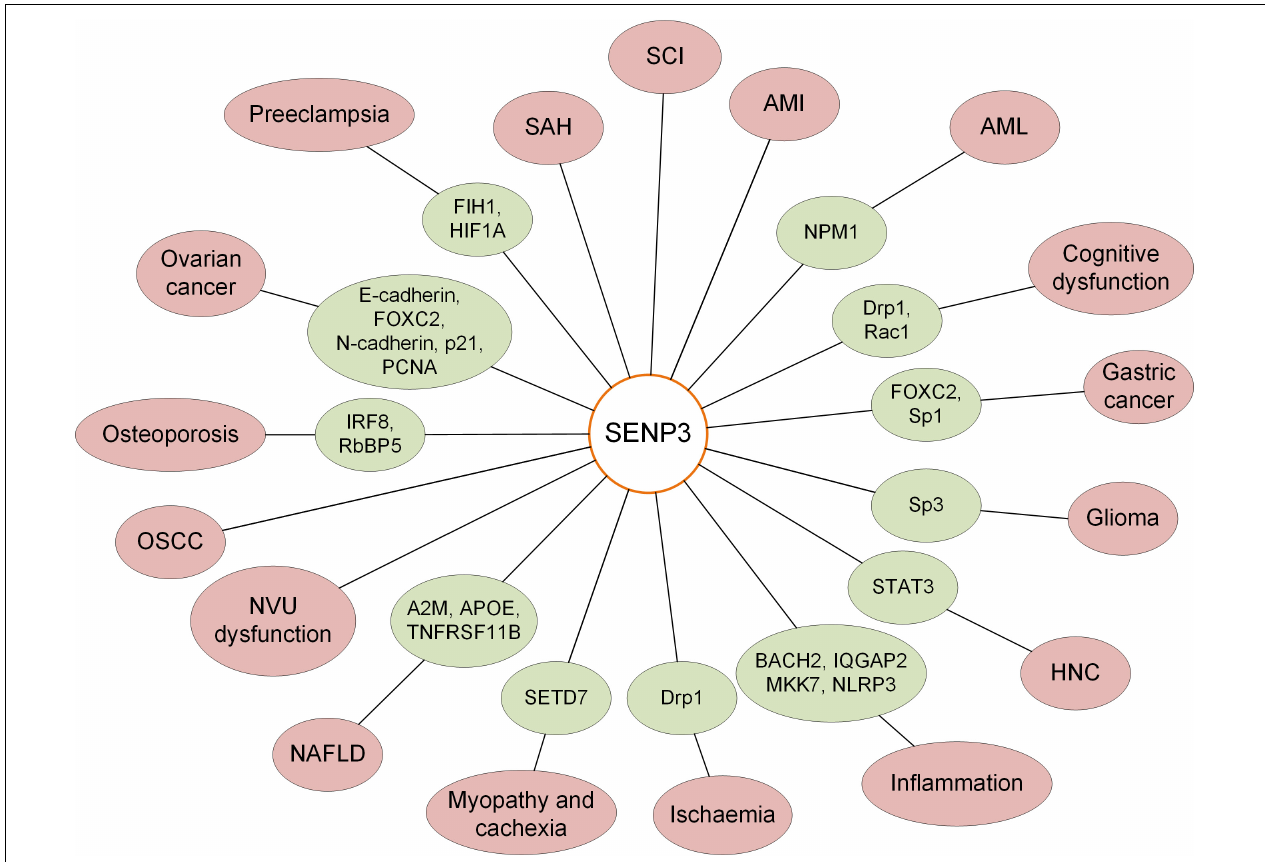
FIGURE 2 | Roles of SENP3-mediated deSUMOylation of substrate proteins in various human diseases.